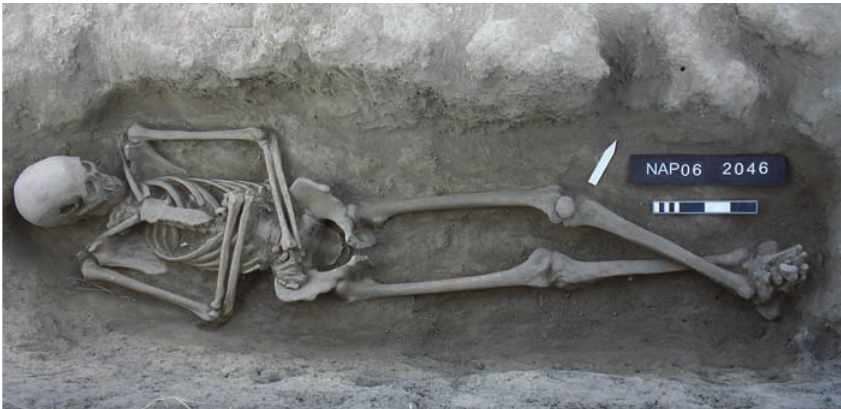
Figure 6 Late Byzantine burial from Area 2